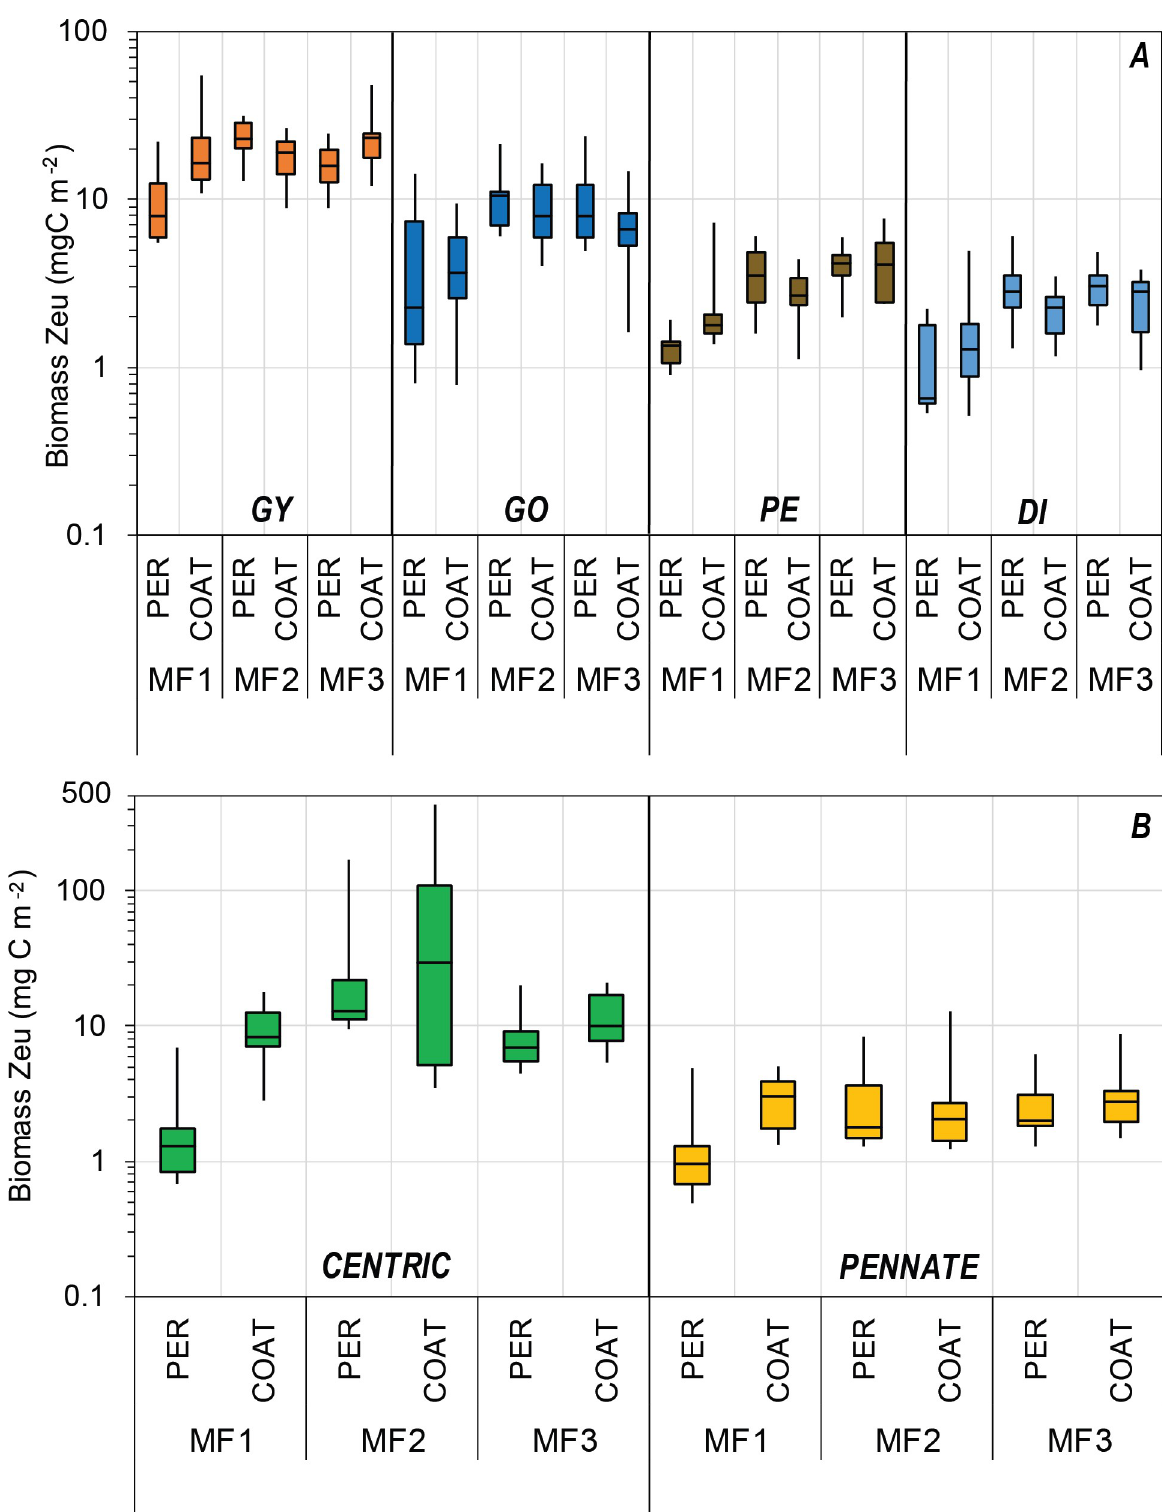
Fig 11. Depth-integrated per-cruise carbon biomass (mg C m -2 ) of dinoflagellate orders and diatom shapes. Median values of integrated carbon biomass (mg C m -2 ) in the euphotic zone of (A) dinoflagellate orders contributing 75% or more to total biomass (box plots at the upper panel) and (B) centric and pennate diatoms (green and yellow box-plots at the lower panel, respectively) at the Perdido (PER) and Coatzacoalcos